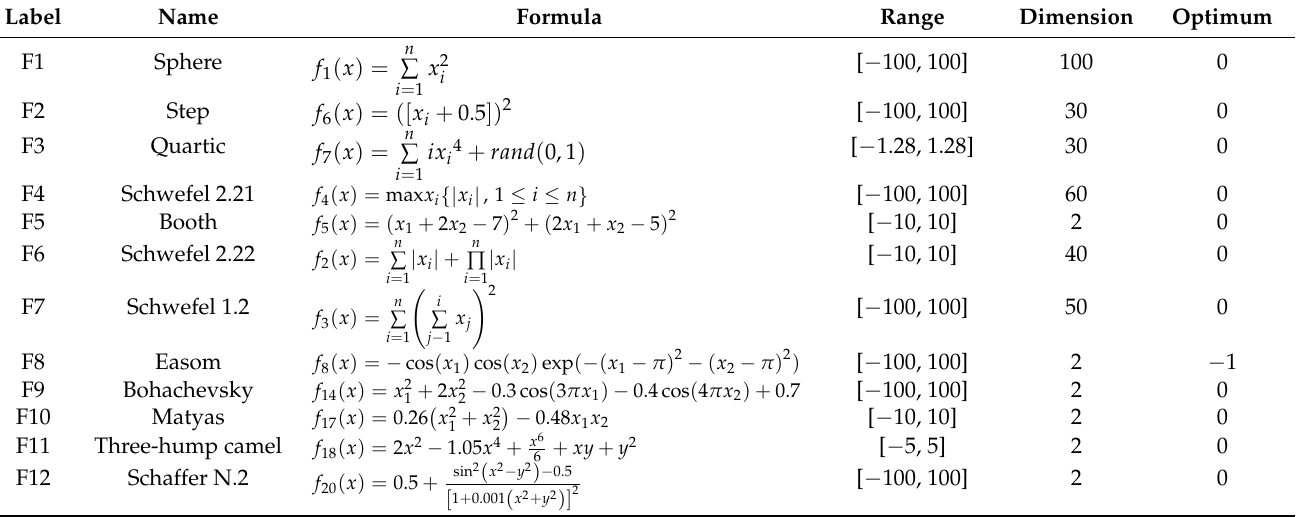
Table 1. Unimodal benchmark